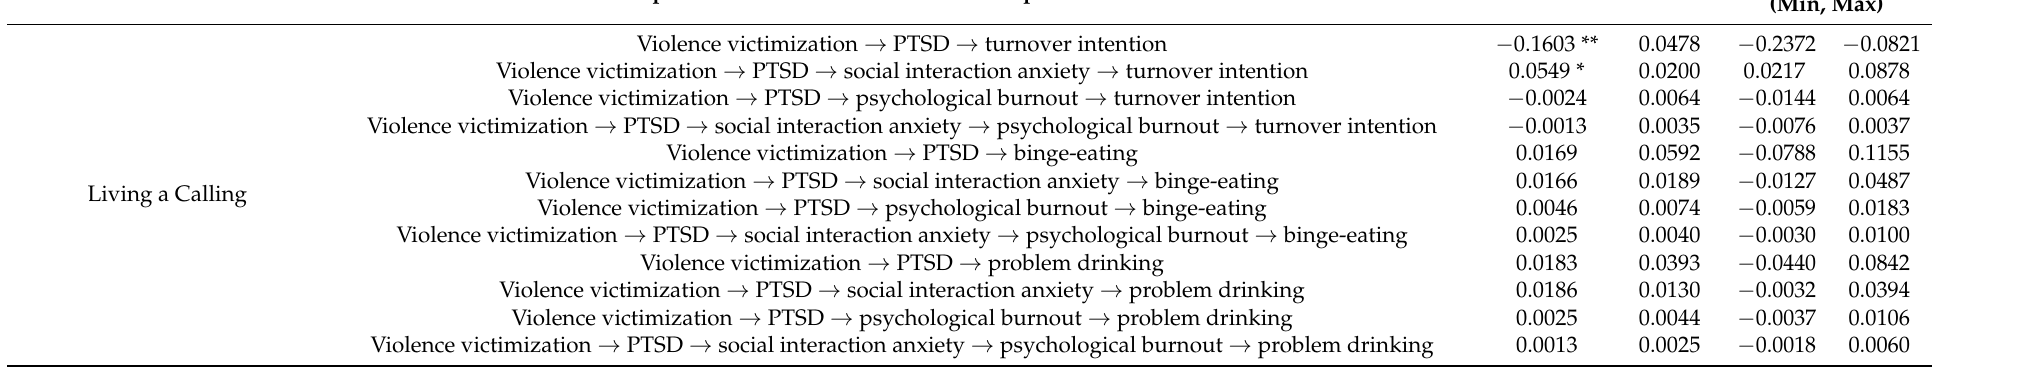
Table 3. Moderated mediating